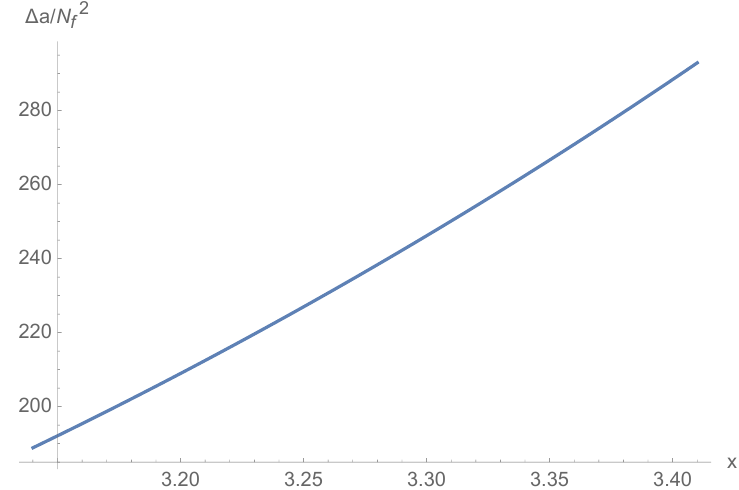
Figure 1 . The di(cid:11)erence of the a central charges between the supposedly UV (cid:12)xed point D 6 and the supposedly IR (cid:12)xed point M 2